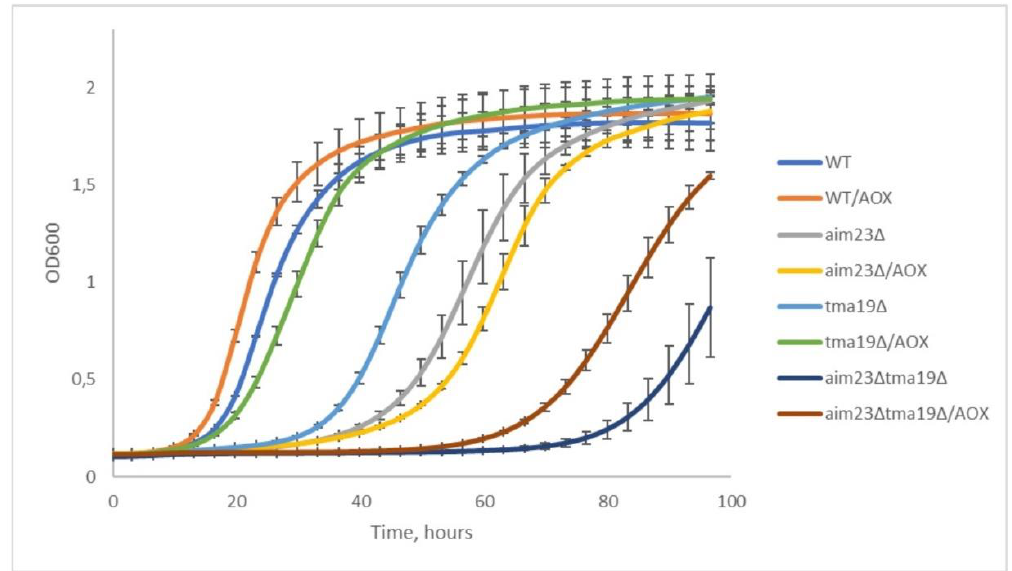
Figure 4. Addition of antioxidants partially rescues the prolongation of lag-phase caused by TMA19 gene deletion. Growth curves of wild-type, aim23 ∆ , tma19 ∆ , and aim23 ∆ tma19 ∆ on YPEG medium with and without antioxidants (AOX) (5 mM N-acetylcysteine and 1 mM α -tocopherol). Yeasts were grown overnight at YPD, washed twice with sterile water, and inoculated into 1 mL of YPEG with or without antioxidants in 24-well plates at OD 600 = 0.01; OD 600 measurements were performed for 96 h every 15 min; experiments were repeated three times, mean values ± SD are presented.